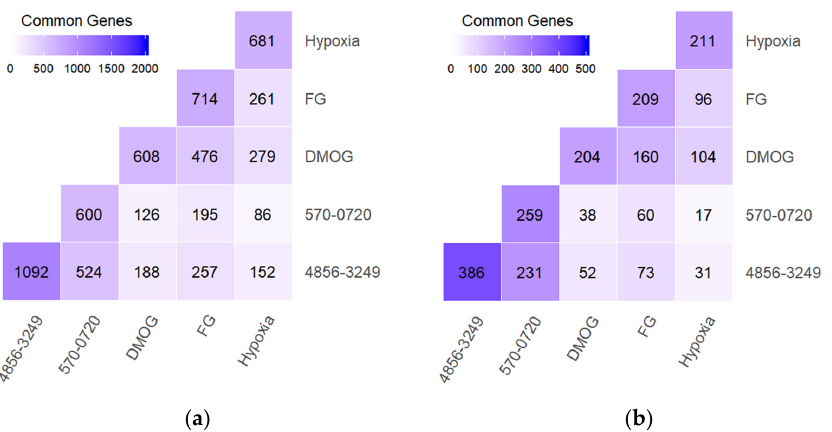
Figure 7. Overlapping genes upon 5 h treatment of human neuroblastoma SH-SY5Y cell line with 0.5 mM DMOG, 30 μ M roxadustat (shown as FG), 2 μ M compounds #4896-3249 and #5704-0720, 0.5 mM DMOG, 30 µ M roxadustat (shown as FG), 2 µ M compounds #4896-3249 and #5704-0720, and 2 h hypoxic treatment followed by 5 h incubation. ( a ) Activation, ( b ) Repression. 1.5-fold change cut-off. Experimental details under Materials and